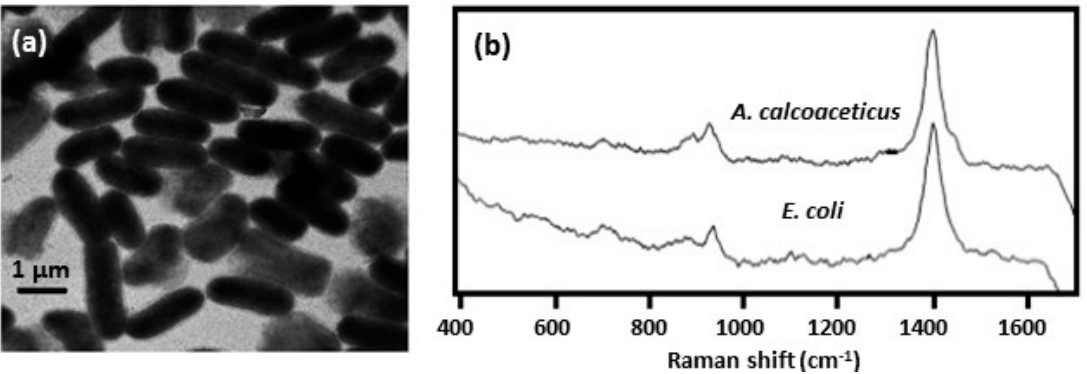
Figure 7. ( a ) TEM image of E. coli infused with Ag colloid [34]. ( b ) SERS spectra of E. coli and A. calcoaceticus infused with silver colloid [34]. Spectra were obtained using 514.5 nm excitation. Reproduced with permission from John Wiley and